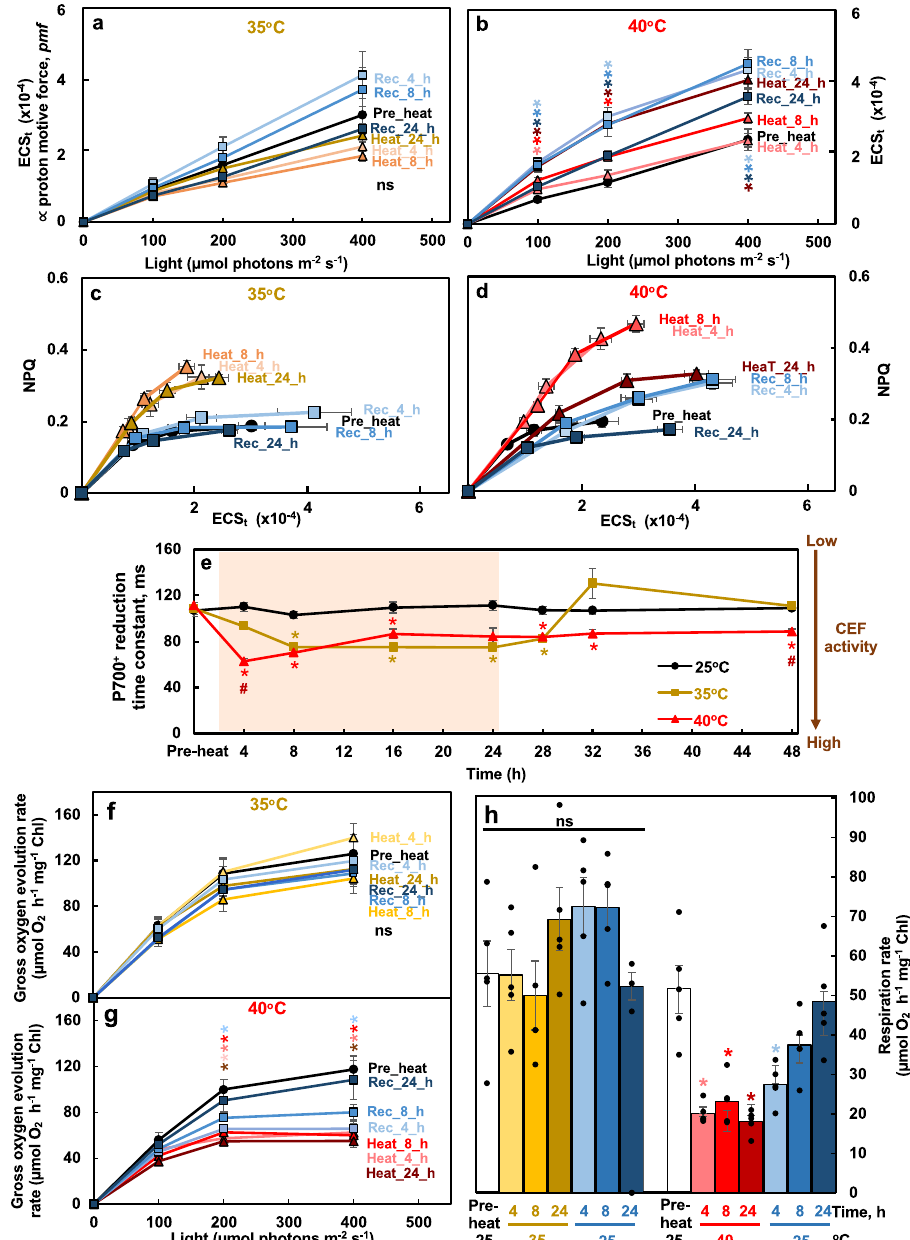
Fig. 8 Heat at 40°C induced transthylakoid proton motive force, NPQ, CEF, but reduced O2 evolution and respiration rates in Chlamydomonas cells. a , b Heat treatment of 40°C increased the transthylakoid proton motive force ( pmf ). ECS t , measured by electrochromic shift (ECS), represents the transthylakoid pmf . c , d NPQ was more sensitive to ECS t (or pmf ) during both heat treatments, with higher NPQ produced at a given pmf . NPQ, non- photochemical quenching, measured using room temperature chlorophyll fl uorescence. e Both 35°C and 40°C induced the activity of cyclic electron fl ow around PSI (CEF) although with different dynamics and reversibility. P700 + reduction to measure CEF in the presence of 10 µ mol DCMU to block PSII activity; the smaller P700 + reduction time constant indicates faster P700 + reduction and higher CEF activity. The red shaded area depicts the duration of the high temperature. f , g , h Gross O 2 evolution rates and respiration rates were reduced during the 40°C heat treatment, measured using a Hansatech Chlorolab 2 Clark-type oxygen electrode. Mean ± SE, n = 5 biological replicates. Statistical analyses were performed using two-tailed t-test assuming unequal variance by comparing treated samples with the pre-heat samples under the same light ( a , b , f , g , h , *) or constant 25°C samples at the same time point ( e , *), or by comparing samples between 35°C and 40°C at the same time point ( e , #). a , b , e , f , g P values were corrected by FDR. *, p <0.05, the colors and positions of asterisks match the treatment conditions and time points, respectively. ( e ) #, p <0.05, the positions of pound signs match the time points. Not signi fi cant,